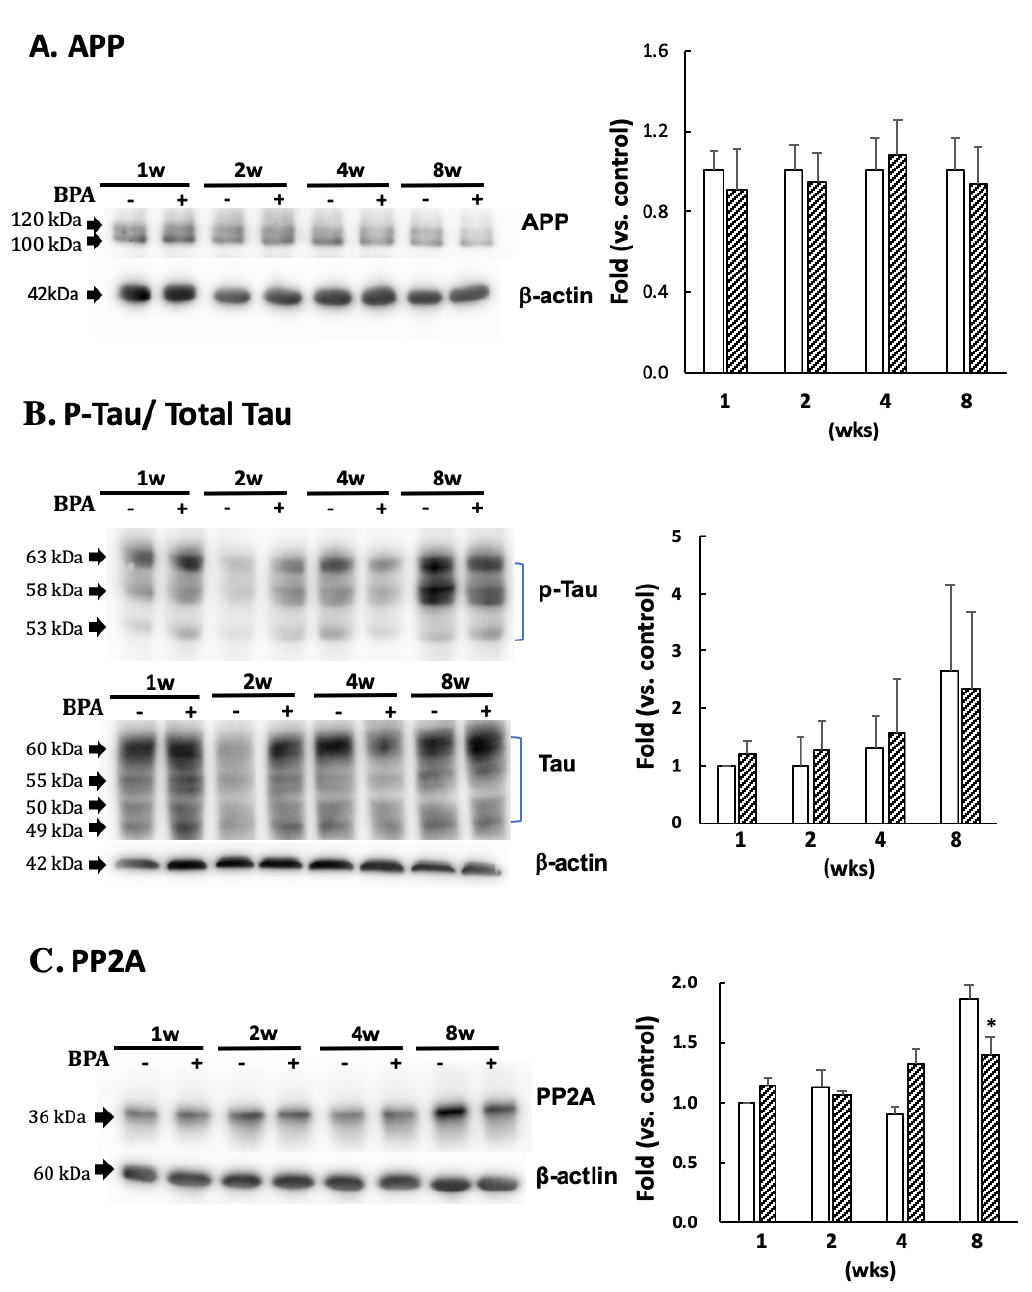
Figure 5. Effect of BPA on APP ( A ); phosphorylated tau protein (PHF1 epitopes)/total Tau ( B ); and PP2A ( C ) levels. Open column, control and gray column, BPA. Values are mean ± SD ( n = 3 to 6). * p < 0.05 as compared with each control group.